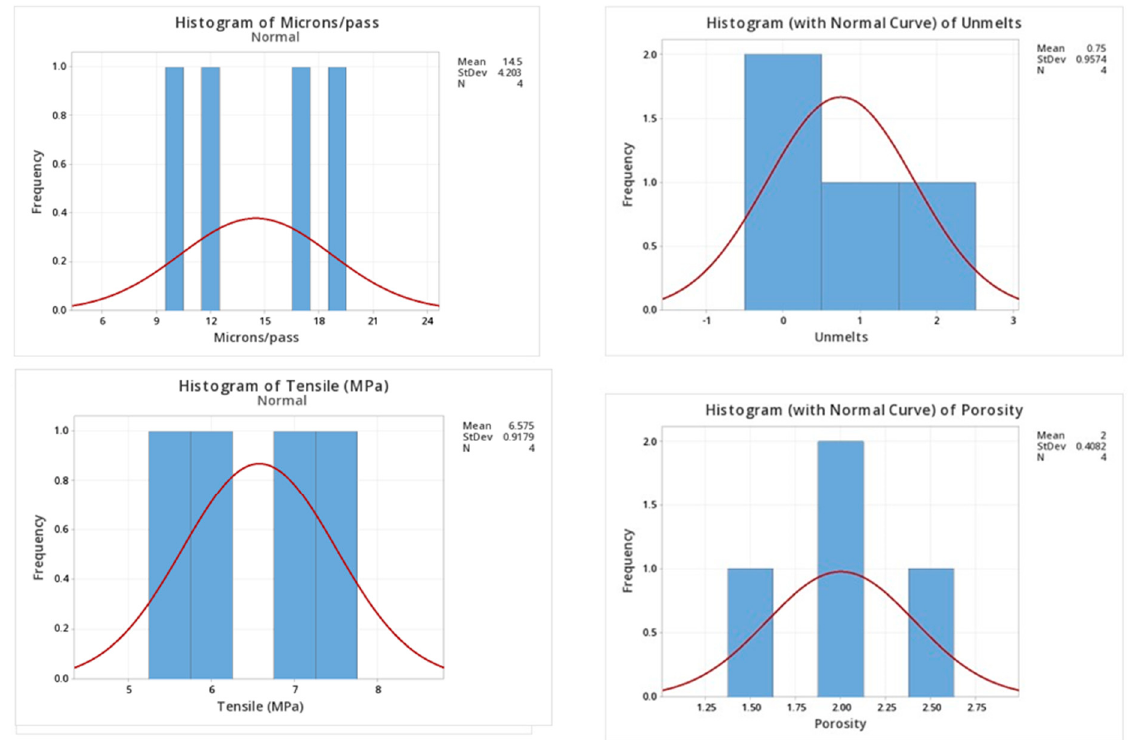
Figure 5. ( a ) Matrix plot of parameters vs. two important coating requirements (kW and m/pass). ( b ) A DOE with five finalised trials with LL (low hydrogen, low spray distance), LH (low hydrogen, high spray distance), HL (high hydrogen, low spray distance), HH (high hydrogen, high spray distance), and MM (medium hydrogen, medium spray distance)—author’s own work.